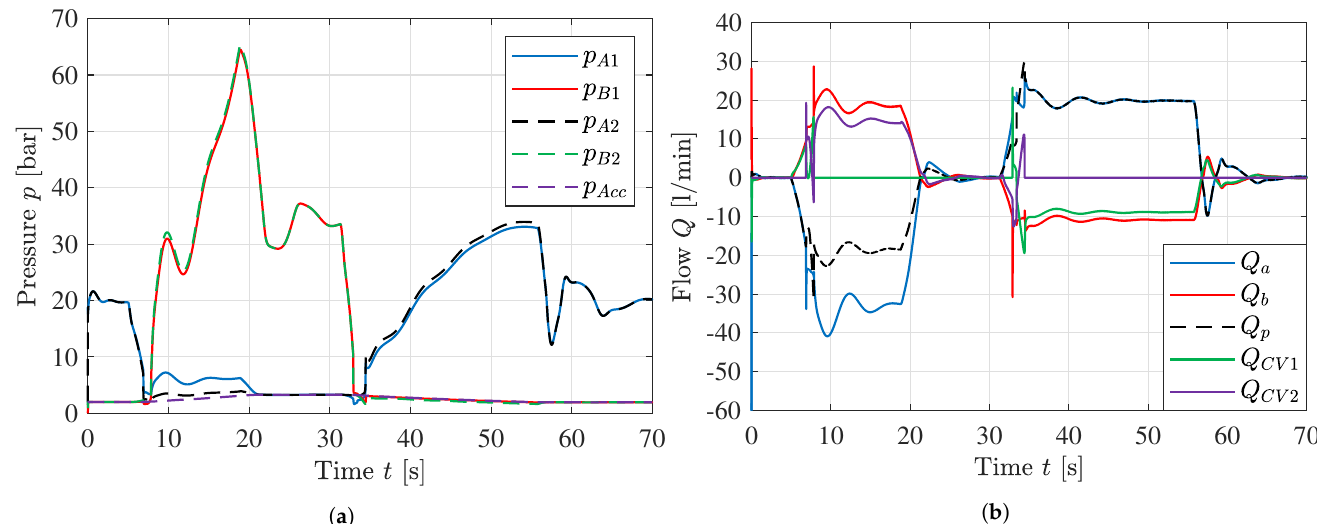
Figure 32. Pressure and flow in the knuckle circuit with EHAs. ( a ) Pressure in knuckle circuit; ( b ) Flow in knuckle circuit.